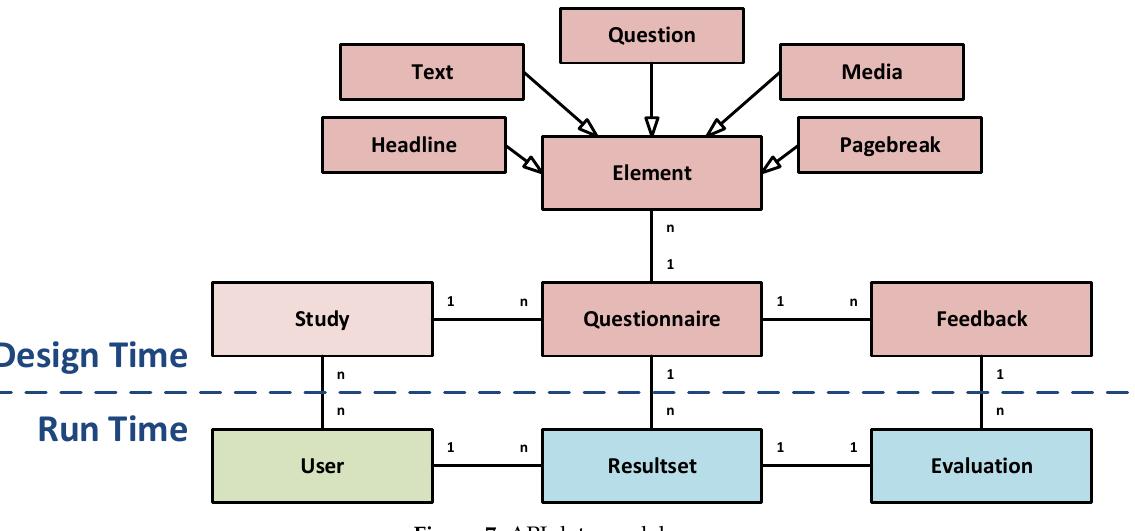
Figure 7. API data